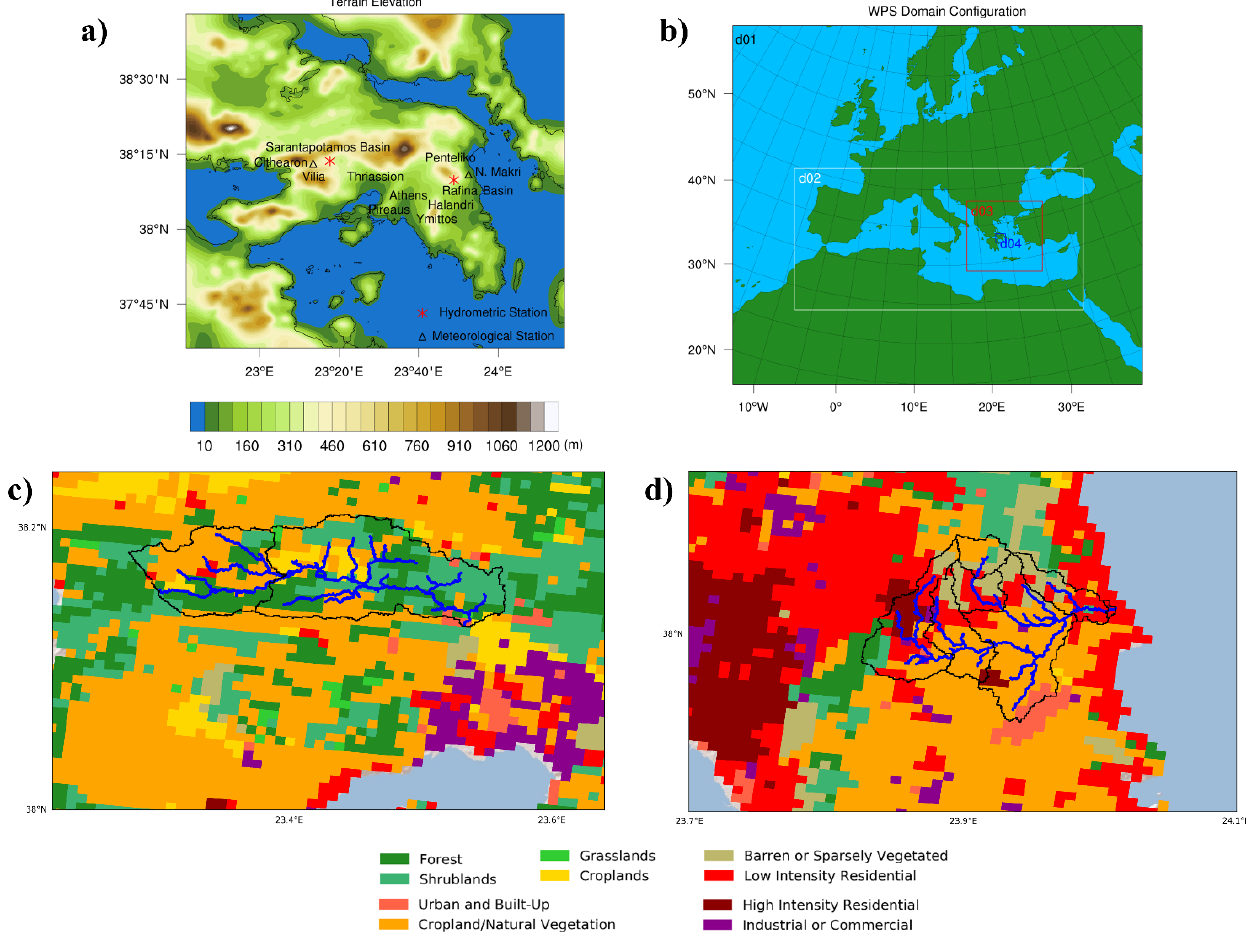
Figure 1. (a) Terrain elevation of the studied domain (obtained by MODIS-IGBP global land cover data) along with two channel networks and the positions of the meteorological (triangle marker) and hydrometric stations (star marker). (b) Modeling domains. The borders of analyzed catchments along with the land cover for (c) Sarantapotamos and (d) Rafina basins.